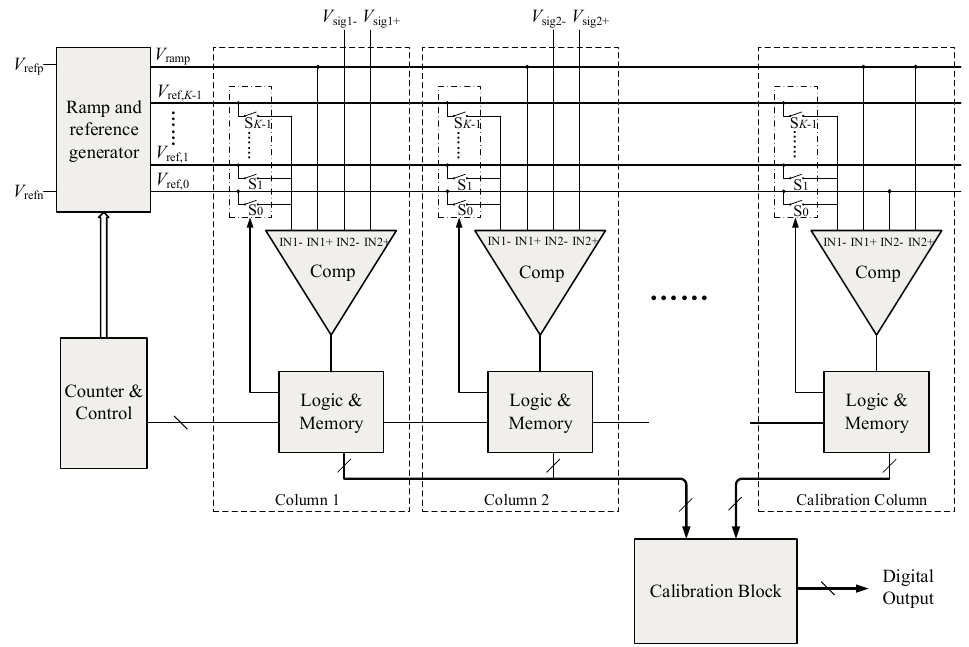
Figure 5. Block diagram of the proposed two-step SS ADC with